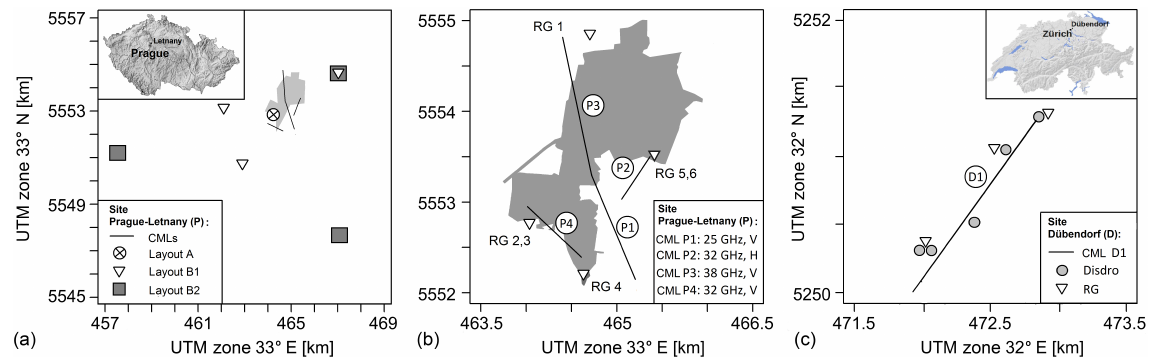
Figure 1. Experimental sites Prague-Letˇnany, CZ (left and middle panels), and Dübendorf, CH (right panel). Left panel: overview CZ, RG layouts used for CML adjusting. Middle panel: detailed view on CZ, CMLs, and reference RGs. Right panel: detailed view on CH, CML, and the layout of reference disdrometers and